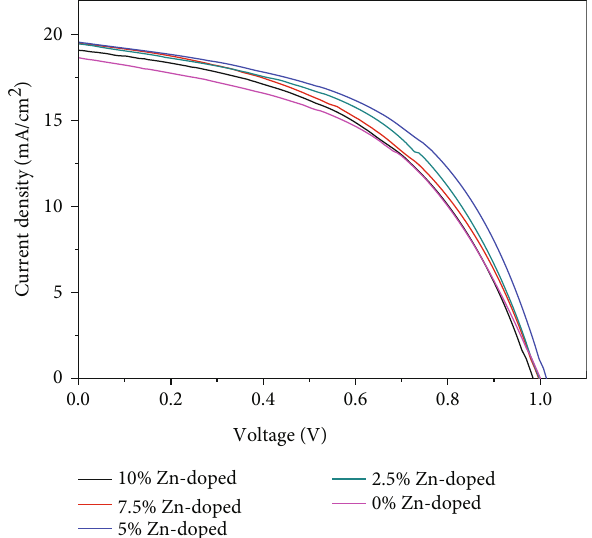
compact layers 2 2